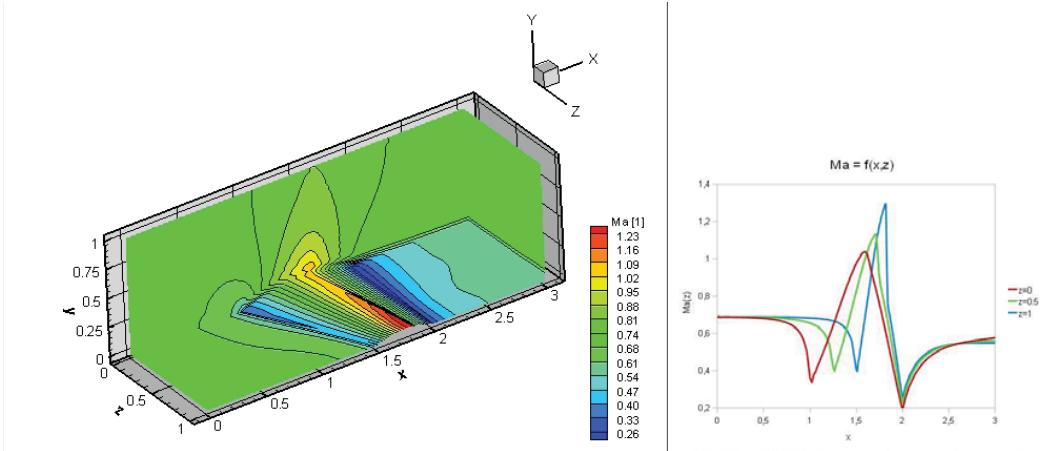
Figure 8: Inviscid compressible flow around the S WEPT W ING in the channel: Mach number isolines at M 1 = 0 . 675 (left) and distributions of Mach number on the lower wall in the slides (right) – RK scheme, IBC A , a structured non-orthogonal grid with 110 × 30 × 10 cells.